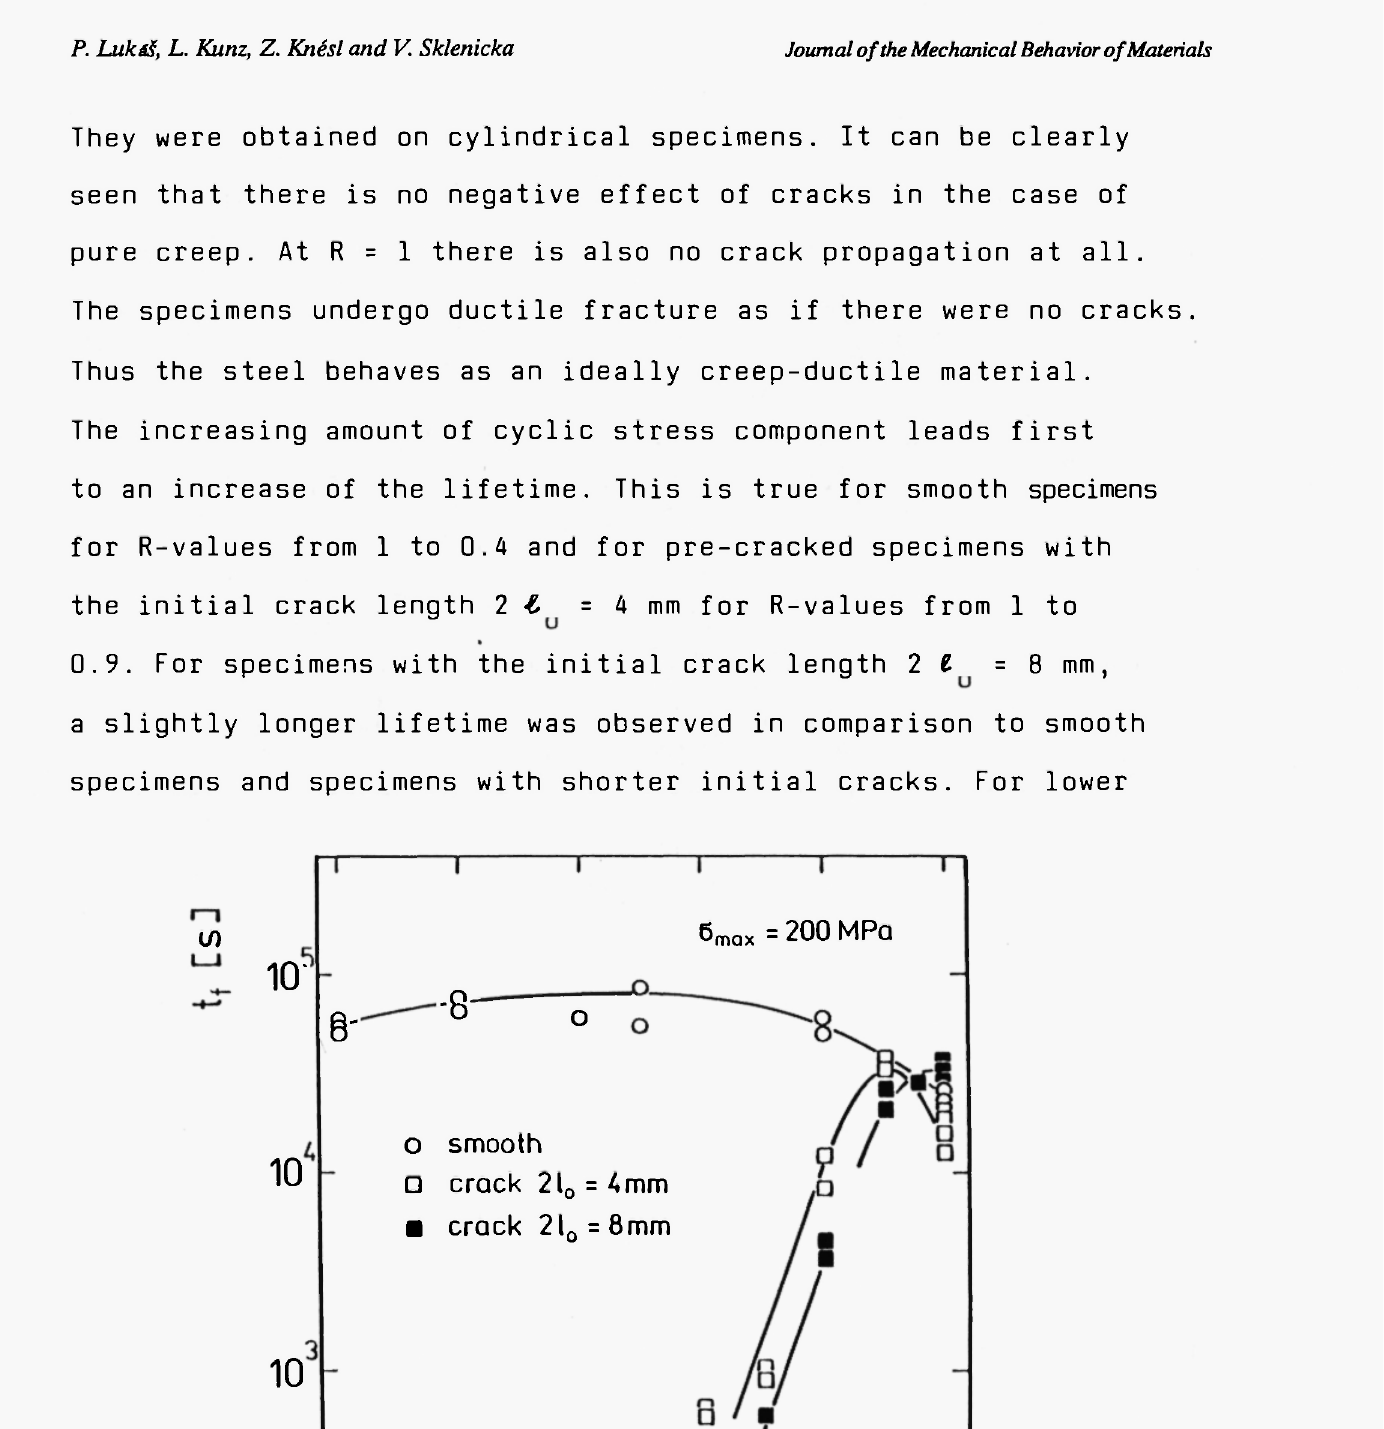
Fig. 3: Lifetime t^ vs. stress ratio R for smooth and pre-cracked